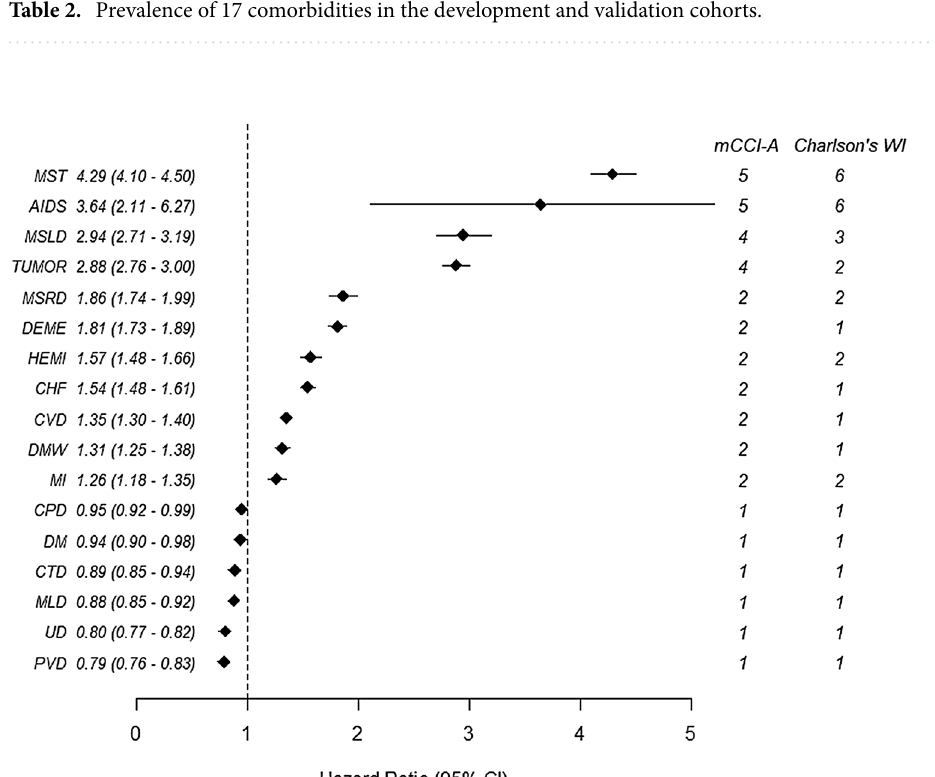
Table 2. Prevalence of 17 comorbidities in the development and validation cohorts.